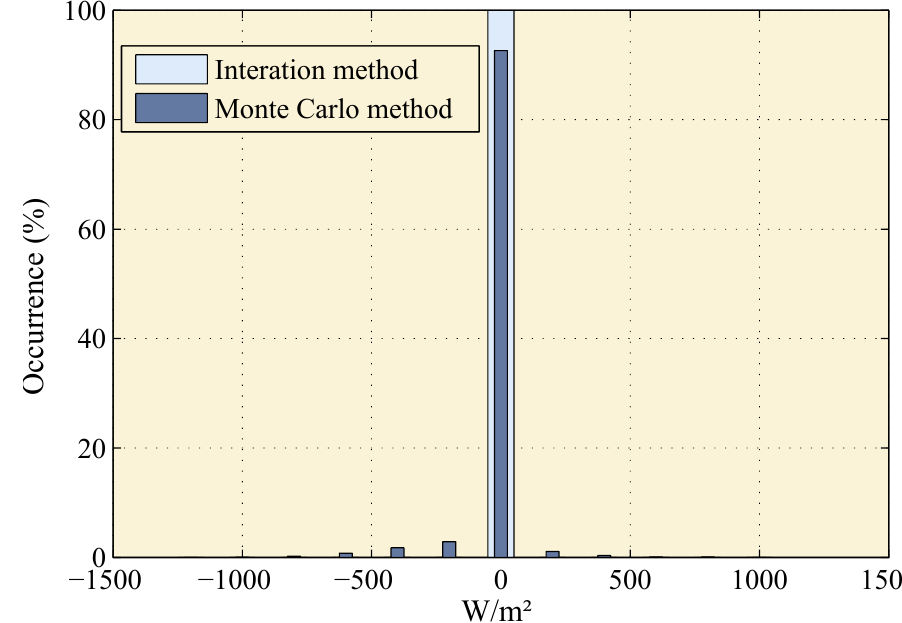
Figure 18. Differences between measured and effective solar radiation.